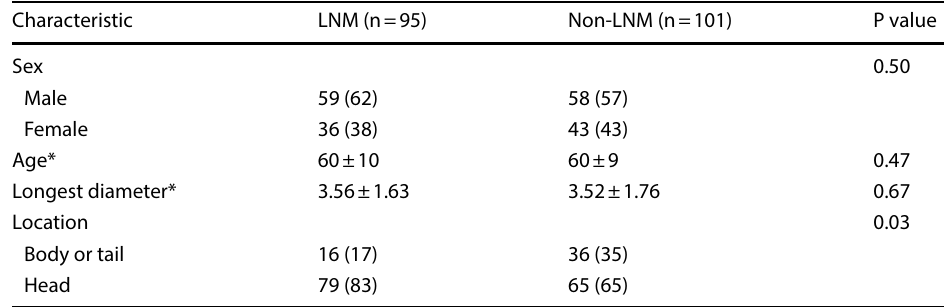
Except where indicated, data are numbers of patients, with percentages in parentheses LNM lymph node